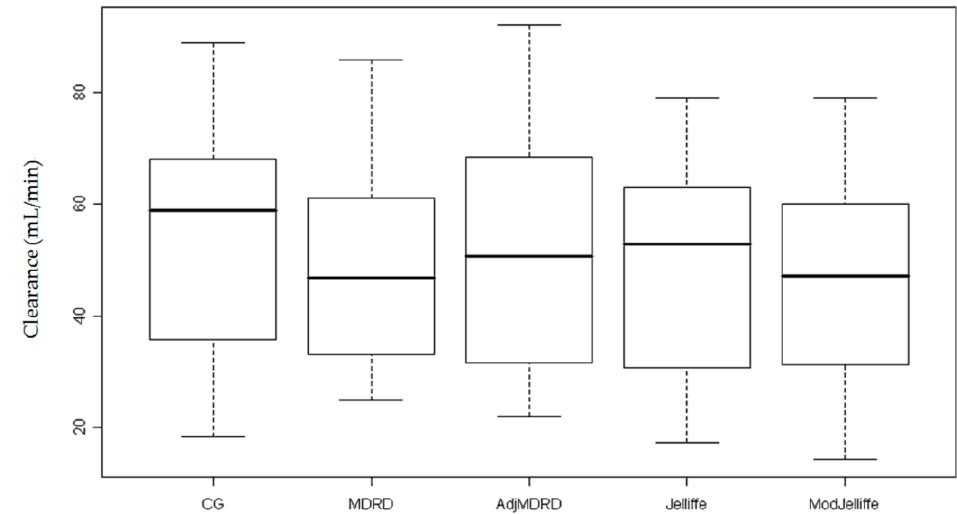
Figure 2. Clearance estimates at recovery of injury. This figure depicts the calculated median clearance at the time of injury recovery using the lowest serum creatinine value in each estimating equation.